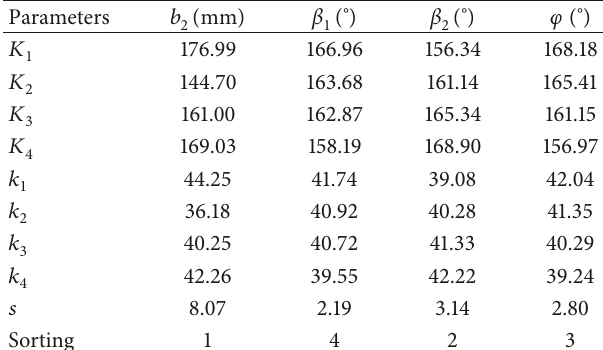
Table 4: Basic parameters of fluid media.